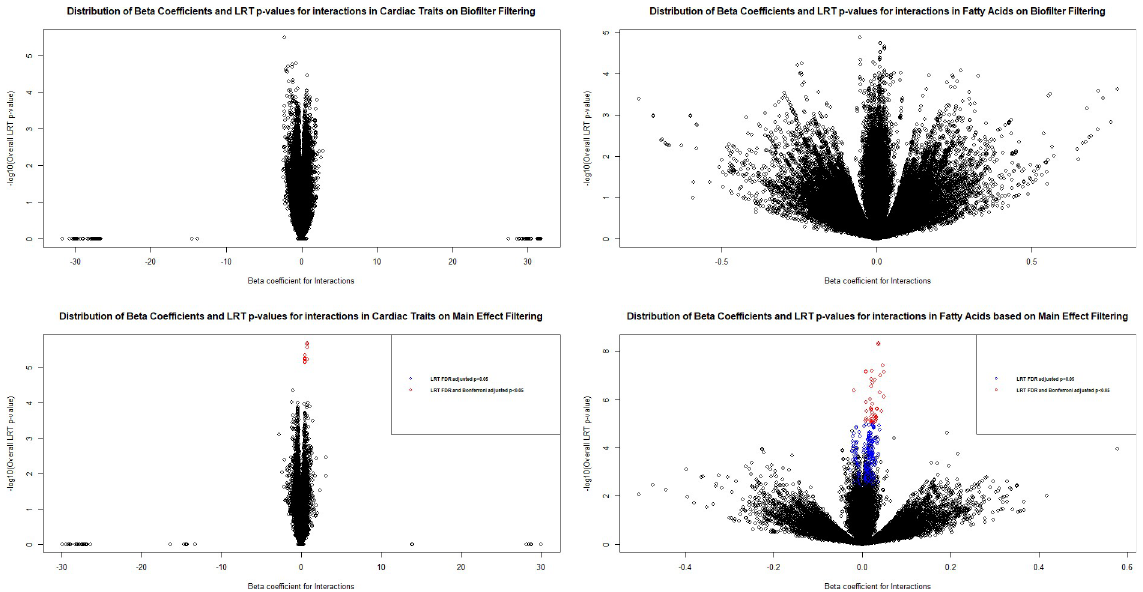
Fig 4. Distribution of interaction beta coefficients and LRT p-values for interactions in cardiac traits and fatty acids under different filtering methods. The beta coefficients and LRT p-values for interactions are plotted by -log 10 (LRT p) against interaction beta coefficient. The significant interactions are highlighted according to the significance level of LRT p-values (blue: FDR-adjusted LRT < 0.05; red: Bonferroni- adjusted LRT p < 0.05).